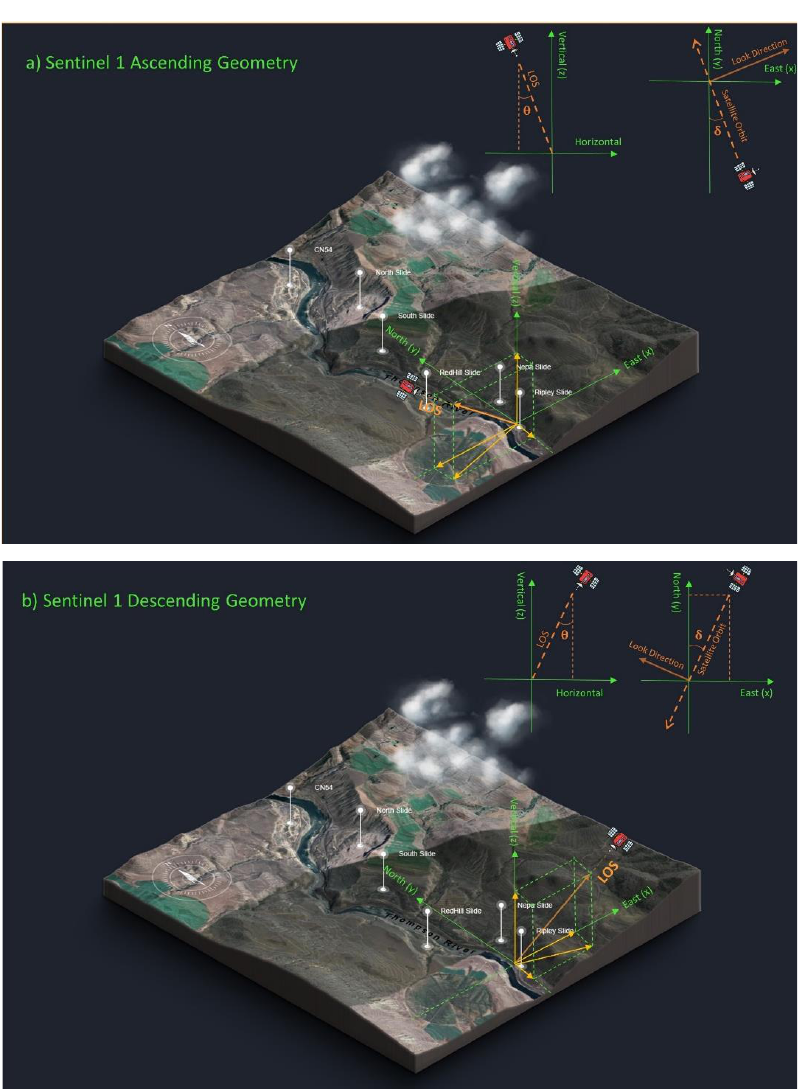
Figure 2. Geometry of the image acquisitions along the ascending ( a ) and descending ( b ) orbits (inspired by Ground Deformation InSAR Analysis over the Thompson Canyon, British Columbia, Technical Details, August 2018, By TRE Group).